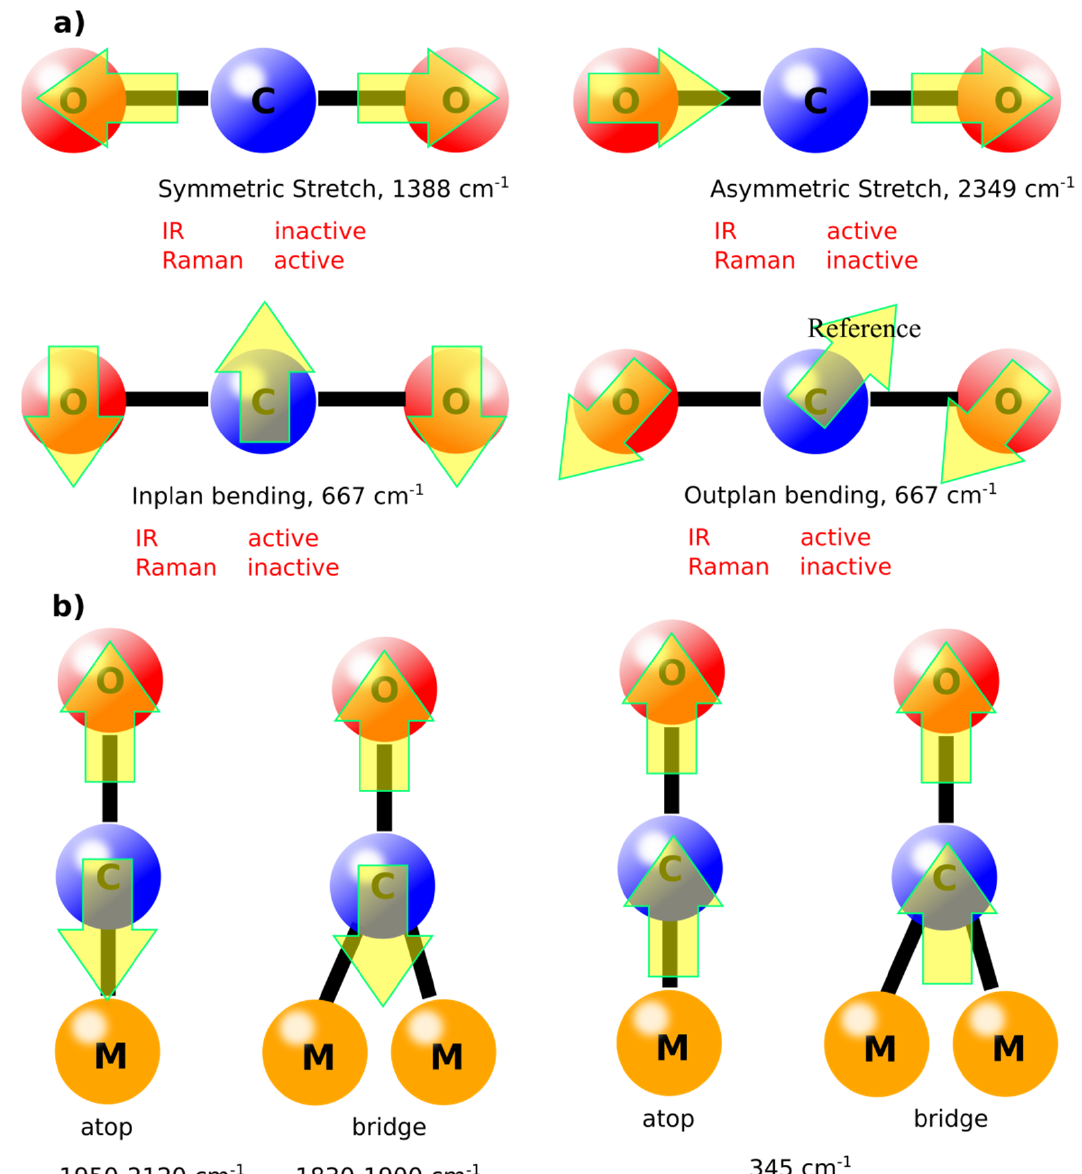
Figure 2. ( a ) Vibrational modes for CO 2 molecules in gas phase showing various associated IR energies. ( b ) Vibrational modes of adsorbed CO molecules on metal surfaces with different modes and associated